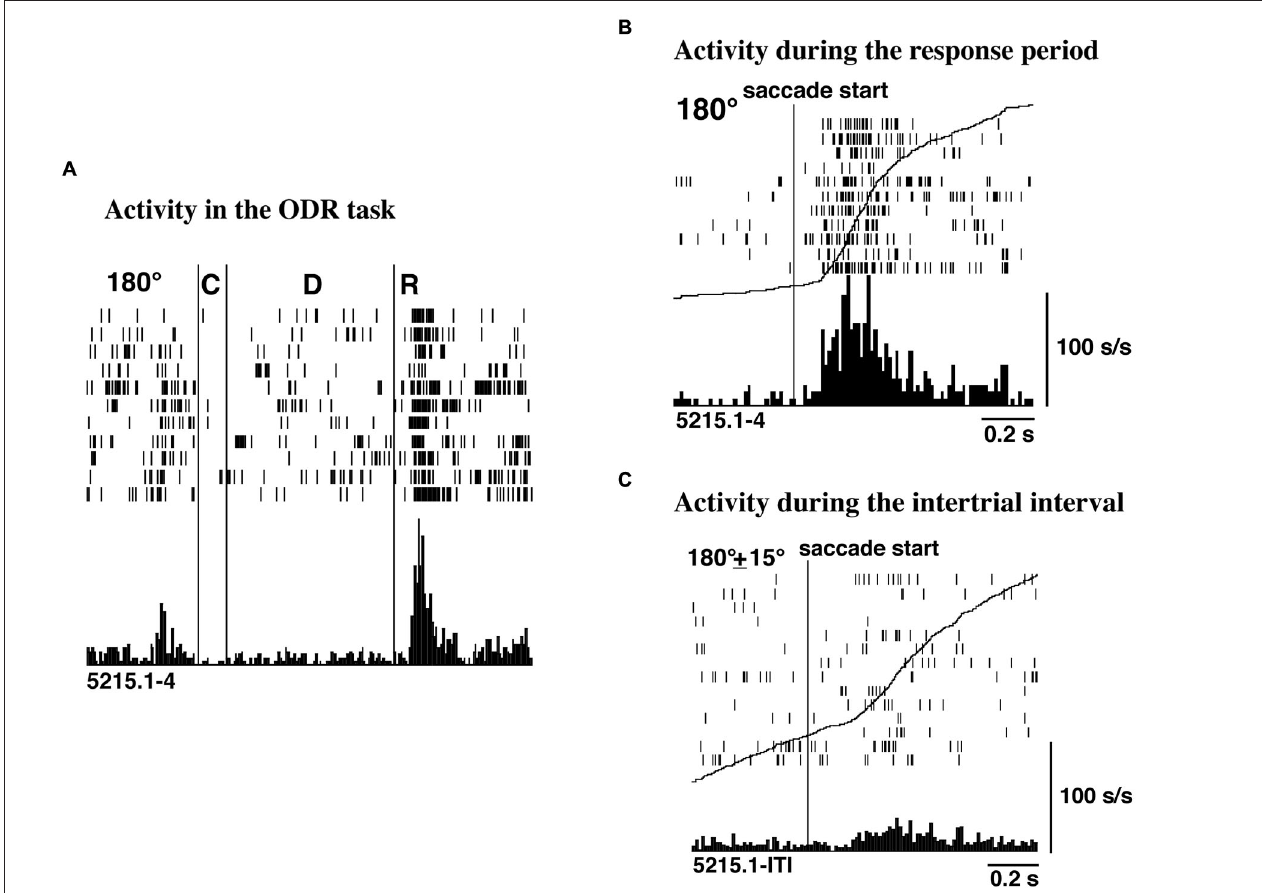
(A) . (C) Activity related to spontaneous saccades occurred during the inter-trial intervals. The activity of the same neuron as shown in (A) . The curves drawn on B and C are not the average traces of the eye movements but the cumulative curves of neuron activities. Adapted from Funahashi et al.